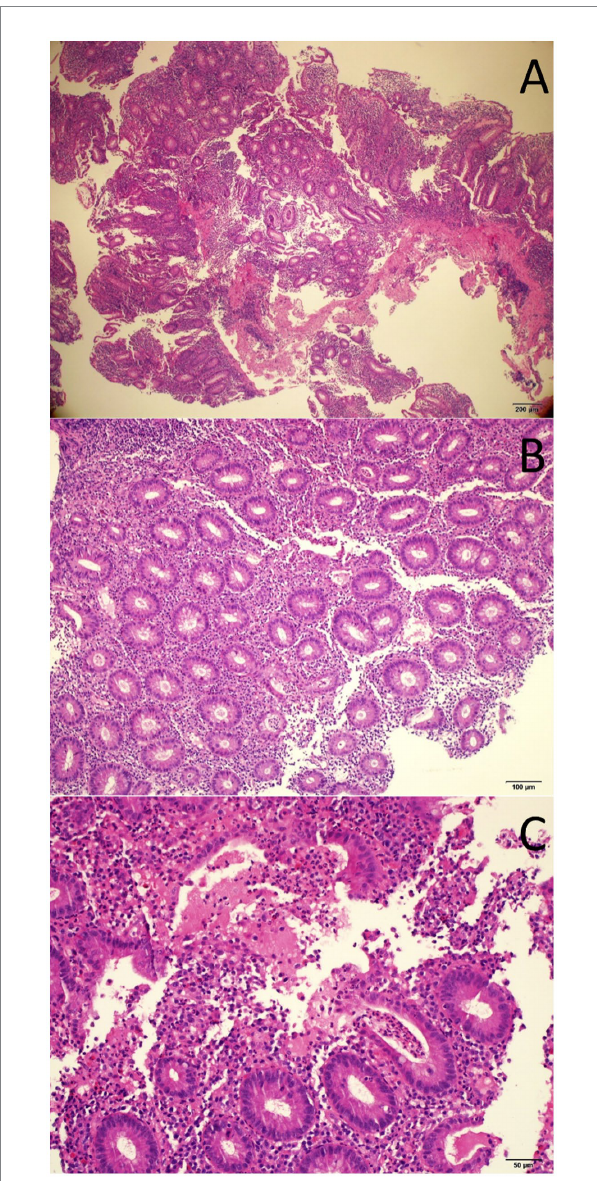
FIGURE 2 Histopathology images of endoscopic colon biopsy showing colonic mucosa with an inflammatory expansion of the lamina propria ( A , H&E 40x), acute cryptitis ( B , H&E 100X), and crypt abscesses ( C , H&E